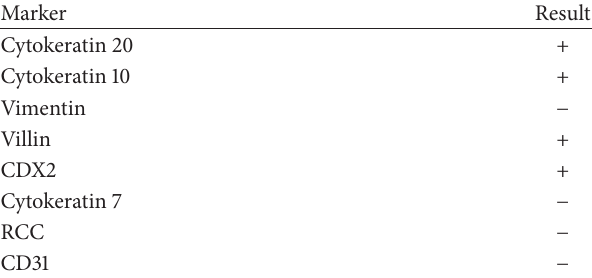
Table 1: Summary of the tumor’s immunohistochemistry